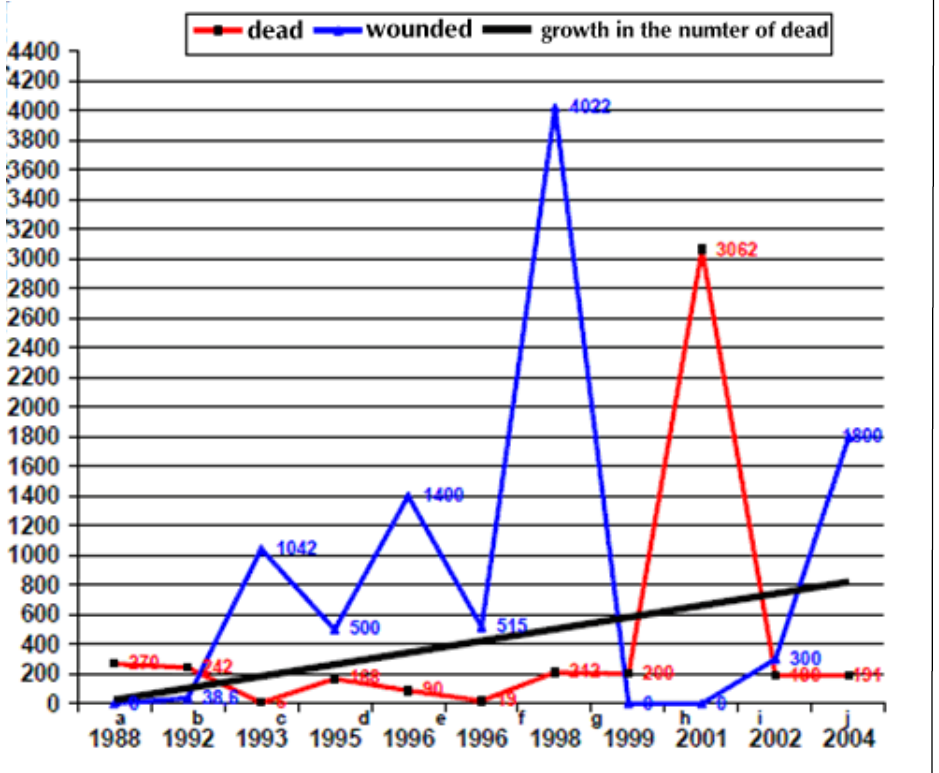
Figure 1 – The number of the dead and the wounded in terrorist attacks 1998-2004 (Ferguson, 2004) Рис . 1 – Количество погибших и раненых в терактах 1998-2004 (Ferguson, 2004) Slika 1 – Broj mrtvih i ranjenih u teroristi č kim napadima 1998–2004 (Ferguson,